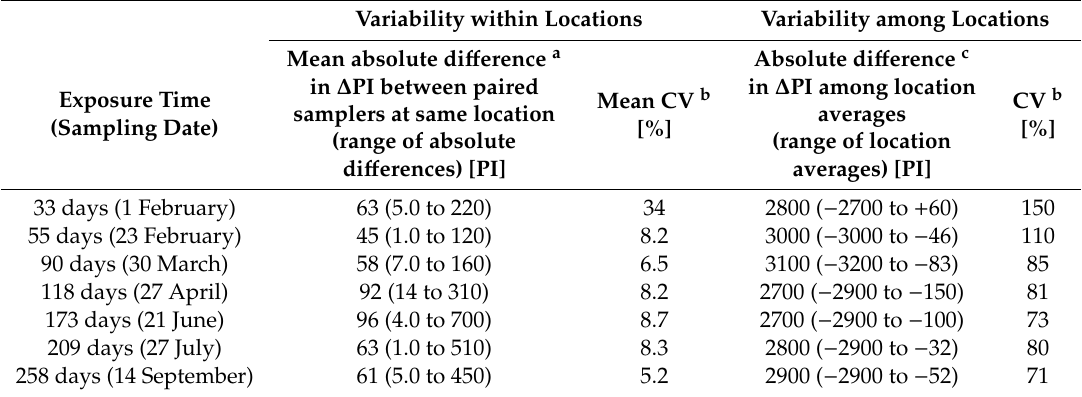
Table 1. Variability in change in reflectance (change in mean pixel intensity ( ∆ PI; unitless)) by sampling date among indoor field locations ( n = 20; based on mean of paired samplers at each location) during 258 days in a community that uses solid fuels.